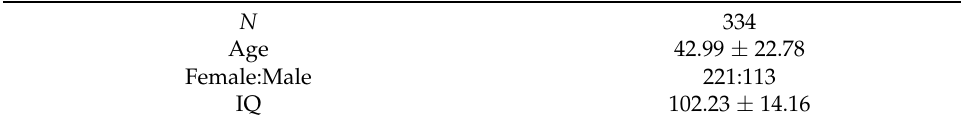
Table 1. Subject Demographics.